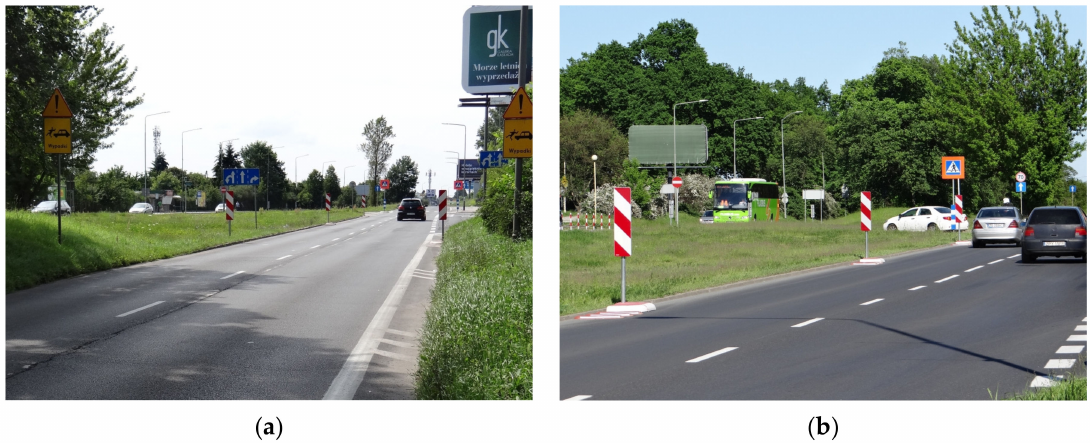
Figure 2. Method of alerting the drivers of the oncoming lane narrowing (three signs U-21 accompa- nied by U-25 separators): ( a ) Westbound carriageway leading from the city centre; ( b ) Eastbound carriageway leading to the city centre.